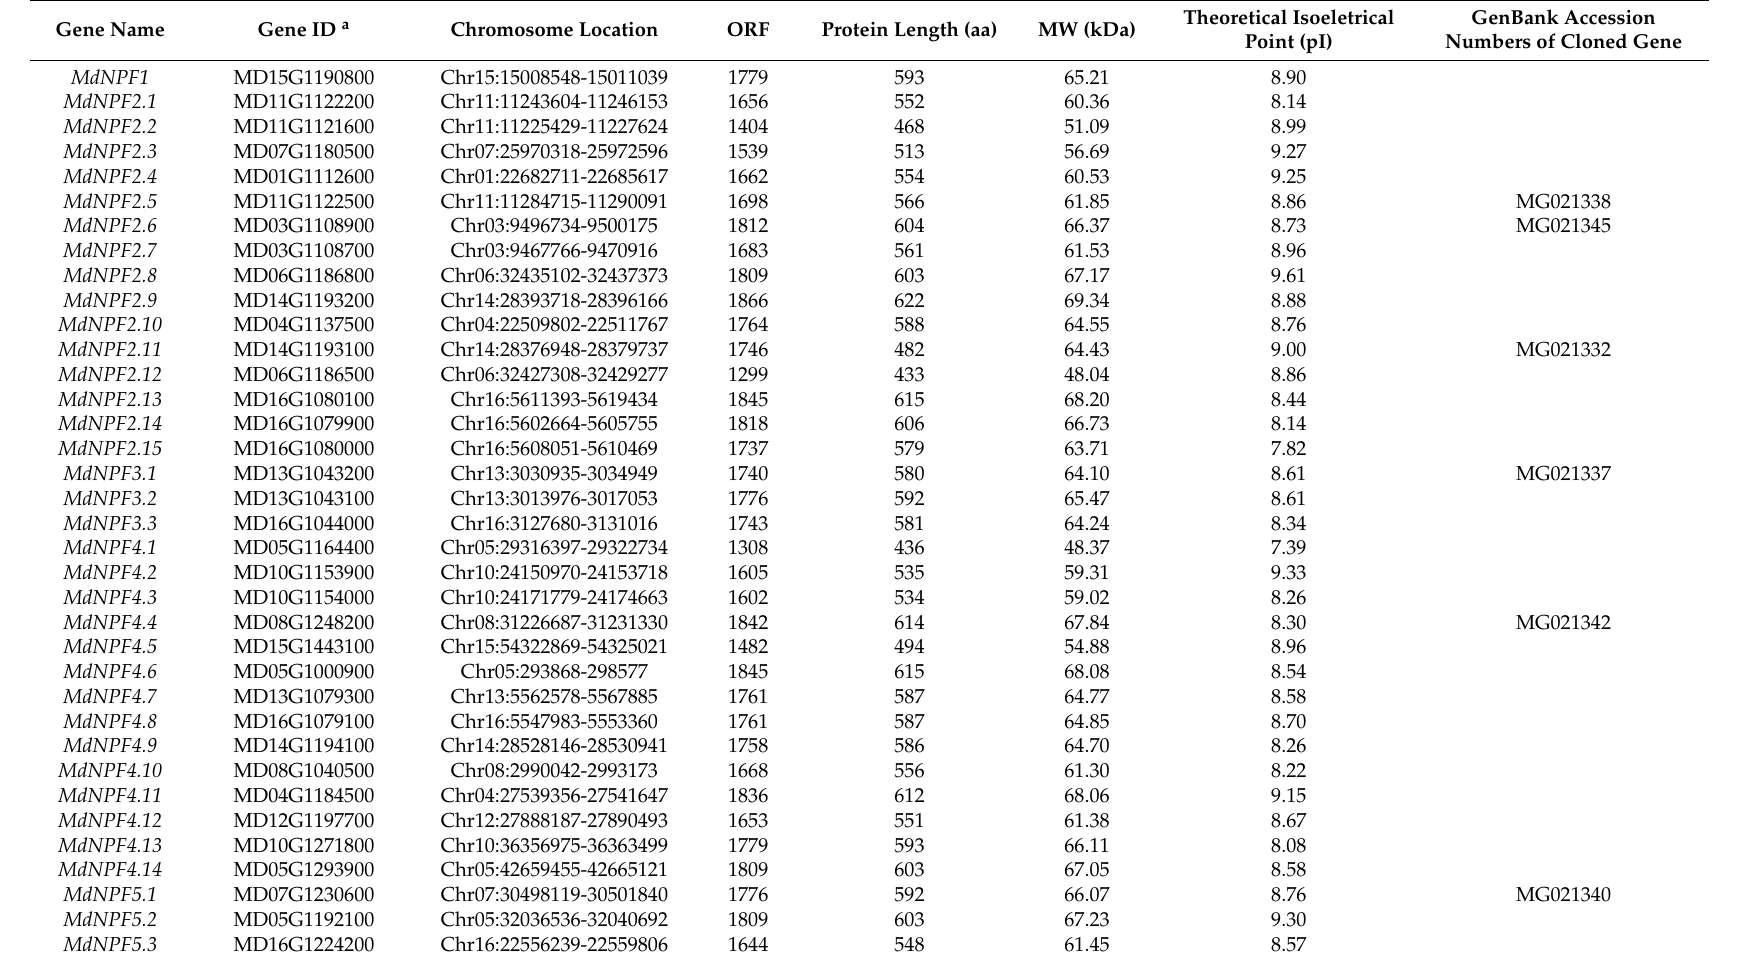
Table 1. Basic information about apple